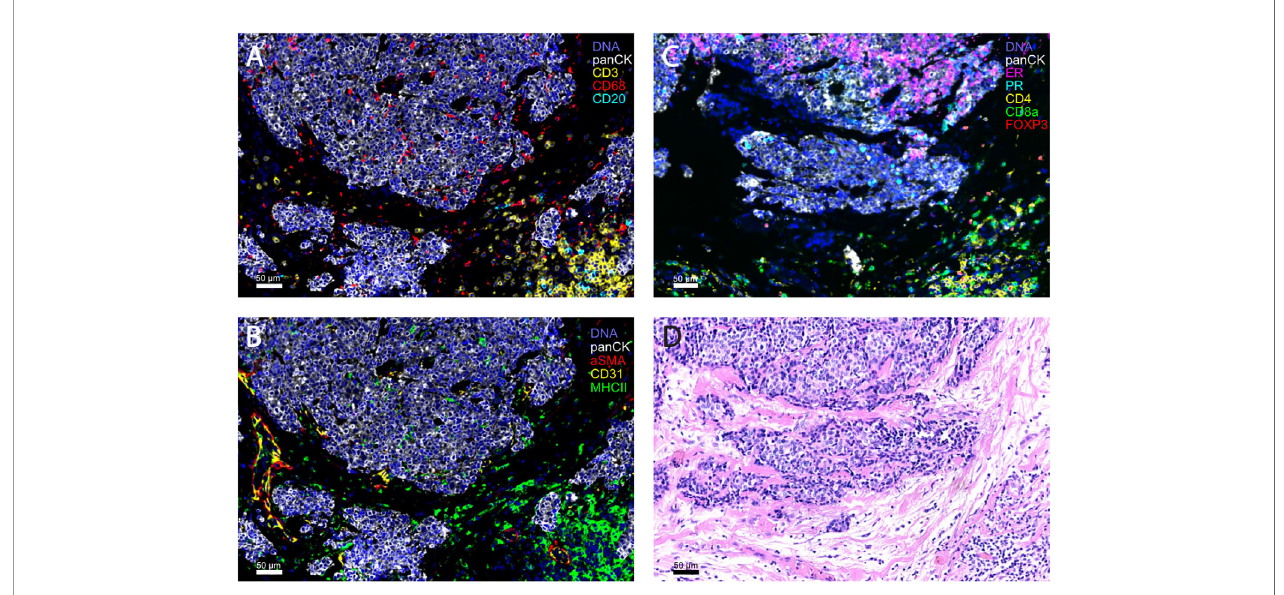
FIGURE 1 | Representative images of HR+ breast tumors obtained with highly multiplex cyclic immuno fl uorescence (CyCIF) imaging (A-C) and the corresponding H&E section (D) . CyCIF is a robust tool for the investigation of the complexity of the tumor microenvironment, by linking the cell type with spatial information. (A, B) are from the same formalin- fi xed, paraf fi n embedded (FFPE) slide and (C, D) are both from serial sections of a primary breast tumor (invasive ductal carcinoma,